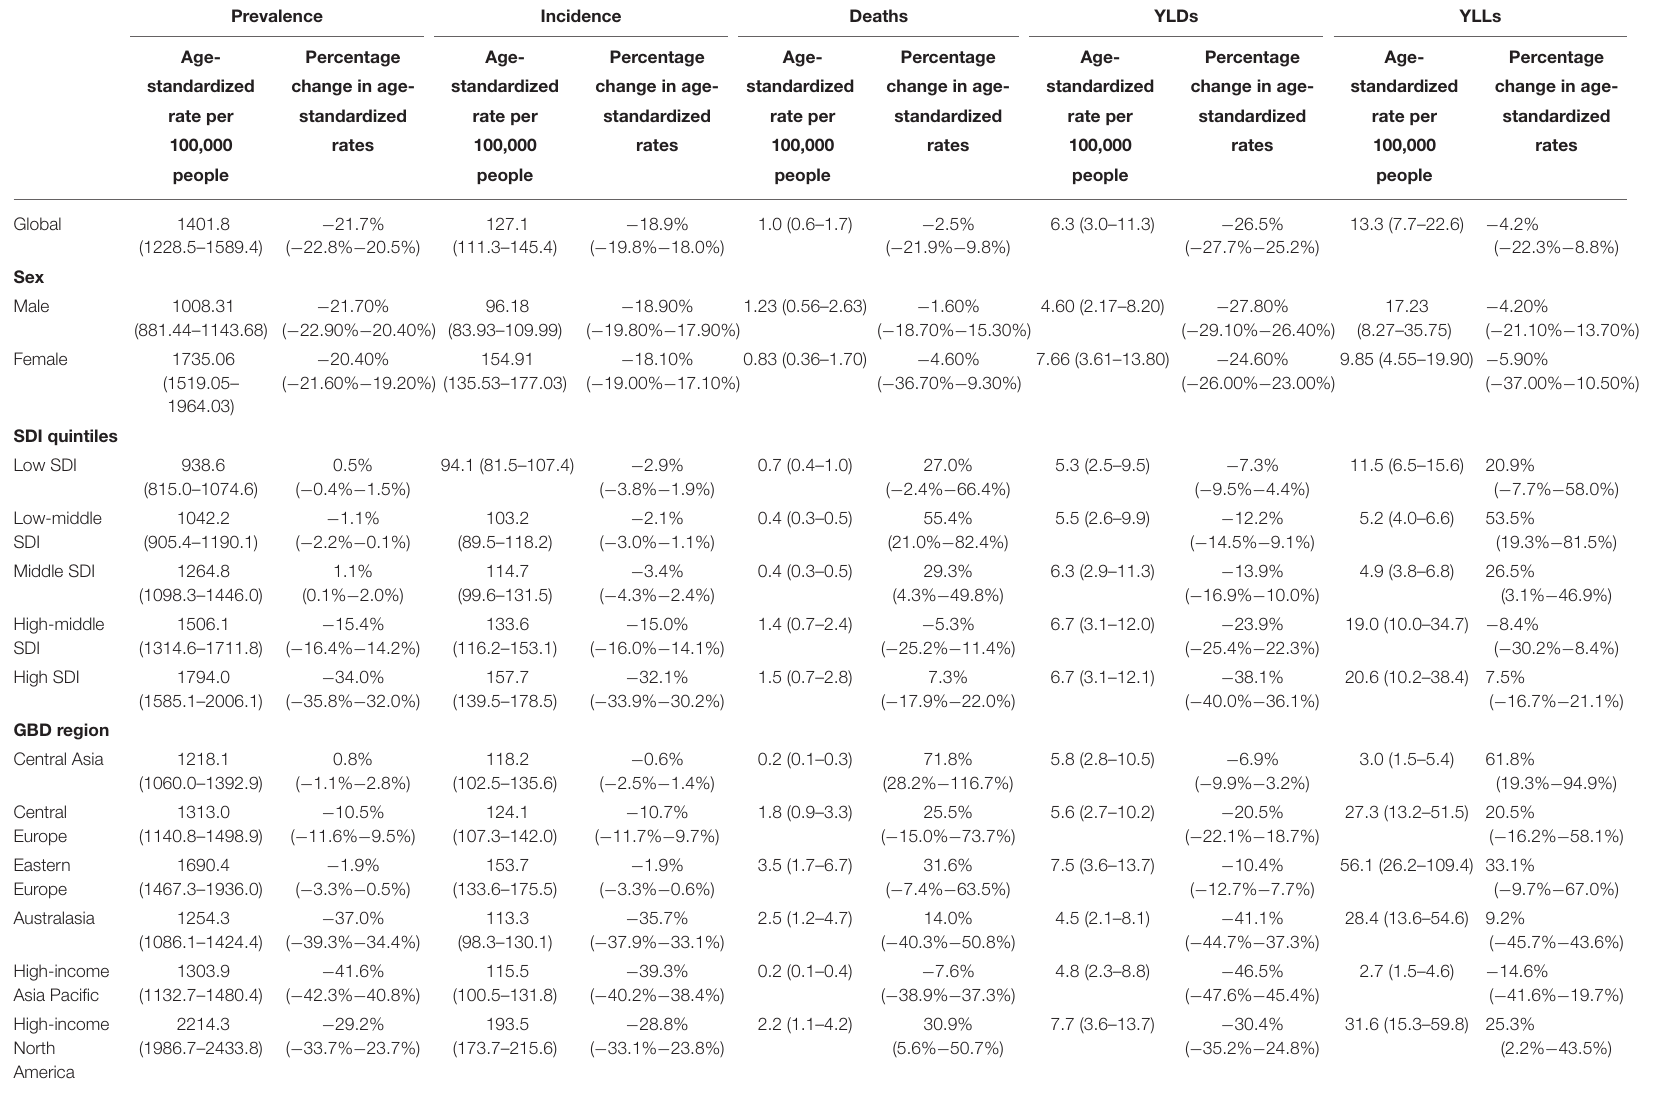
TABLE 1 | Age-standardized prevalence, incidence, death, YLD, and YLL rates of peripheral artery disease in 2019, and their percentage changes from 1990 to 2019, by sex, SDI quintile, and GBD